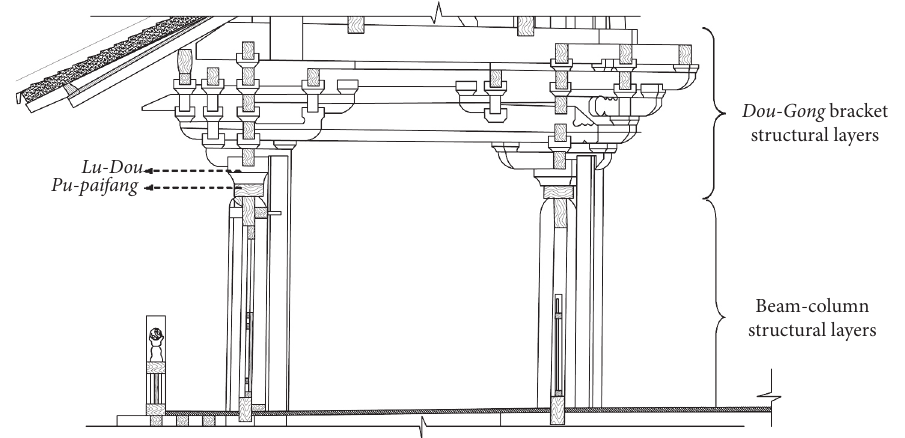
Figure 4: Major components of the third